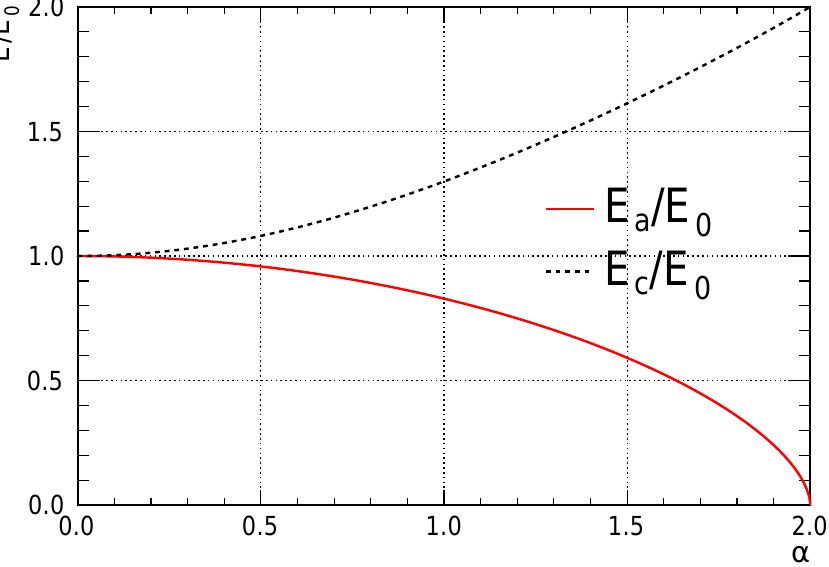
Figure 5. Normalized electric field at the anode E a / E 0 and cathode E c / E 0 as a function of the parameter α , reproduced from Ref. [6].